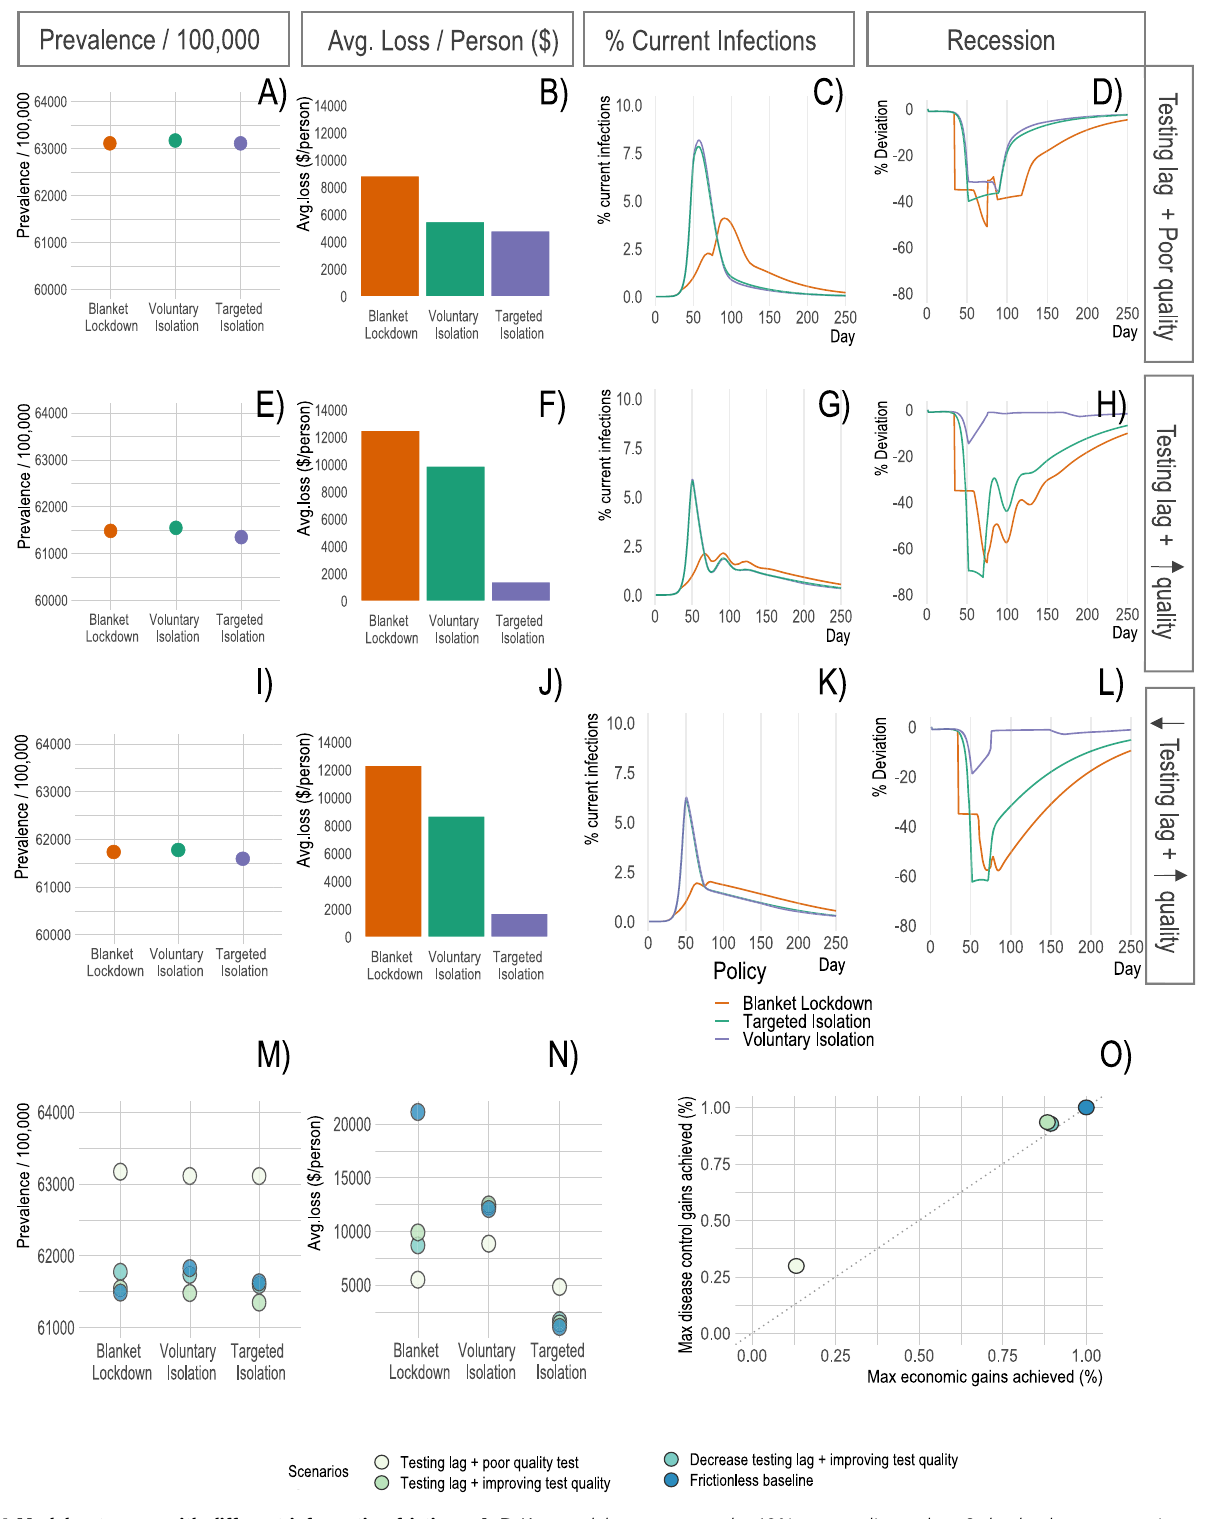
Fig. 4 Model outcomes with different information frictions. A – D Key model outcomes under 10% test quality and an 8-day lag between testing and reporting. E – H These outcomes when test quality linearly improves from 10% to 95% quality by day 75 under a constant 8-day test reporting lag. I - L These outcomes when test quality linearly improves as before, and the test reporting lag reduces from 8 days to 5 days at day 60 then from 5 days to 3 days at day 75. M , N How disease-economy outcomes vary across these scenarios. O The disease-economy outcomes under these scenarios relative to the baseline in Fig.